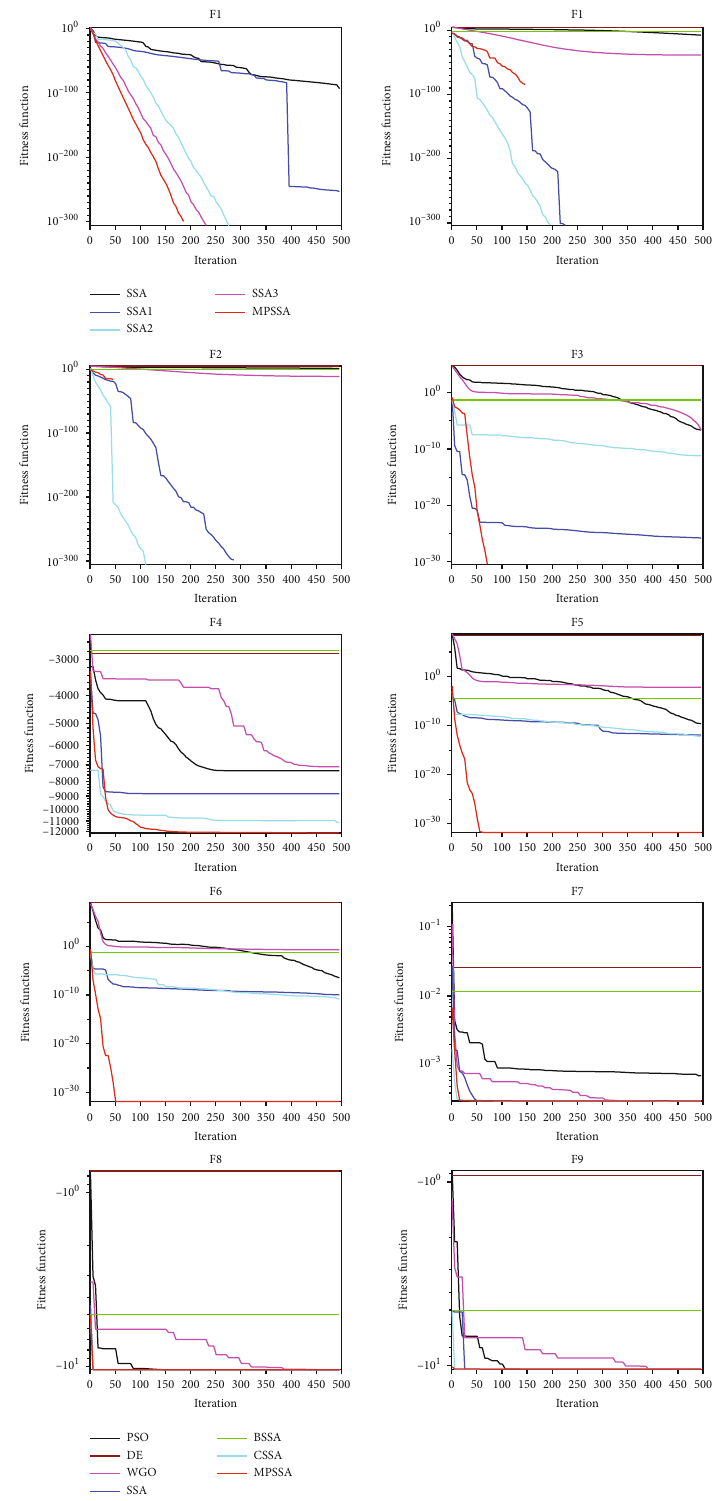
Figure 6: Comparison of algorithm